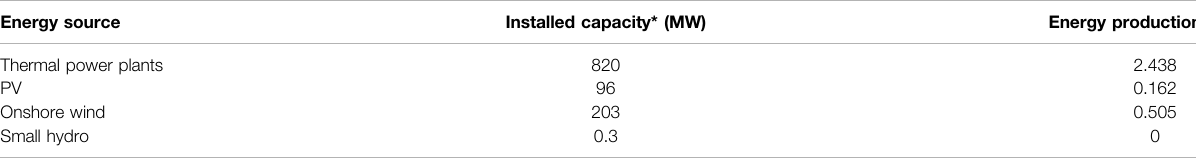
TABLE 1 | Installed capacities for power production facilities in 2019.